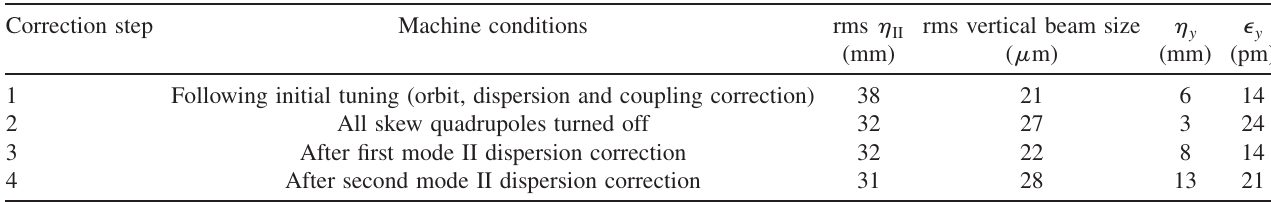
TABLE III. Results of a test of emittance tuning in CesrTA using correction of mode II dispersion. The rms of the mode II dispersion is calculated over the values measured at the BPMs. The vertical beam size is measured using an x-ray beam-size monitor (xBSM). The ) is measured at the BPM closest to the source point for the xBSM. vertical dispersion ( (cid:7) y Correction step